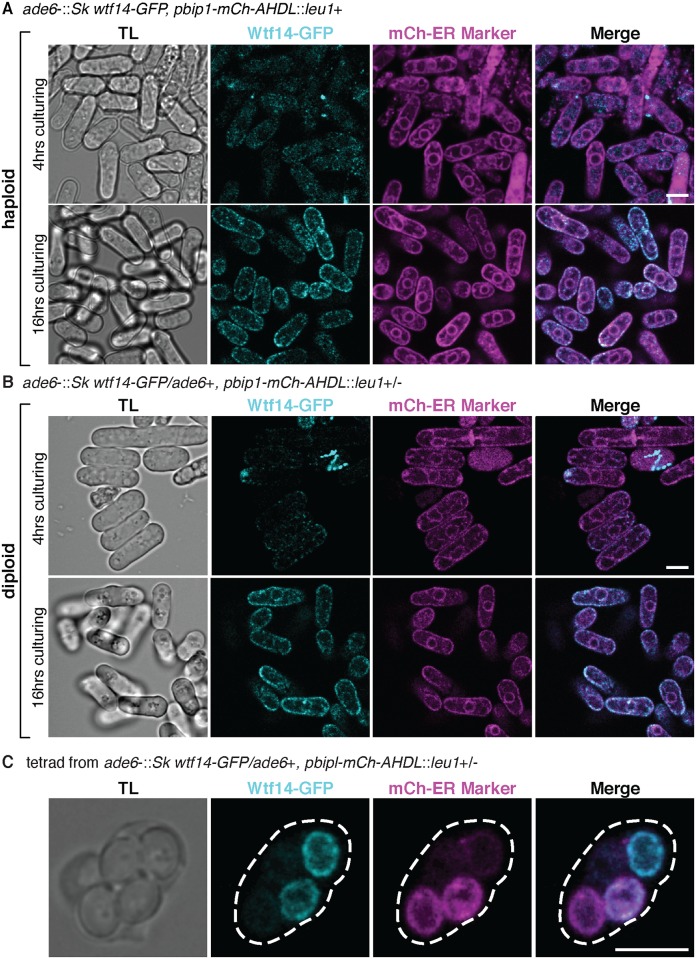
Sk wtf14-GFP is broadly expressed and localizes to the perinuclear endoplasmic reticulum (ER).Representative images of Sk Wtf14-GFP (cyan) and ER marker mCherry-AHDL (magenta) in (A) haploids and (B) diploids after 4 hours and 16 hours of culturing. The imaged diploids were heterozygous for both Sk wtf14-GFP and pbip1-mCh-AHDL. (C) Tetrad generated by a diploid heterozygous for Sk wtf14-GFP and pbip1-mCh-AHDL. We linearly unmixed the images in A and B (see Materials and methods, S10 Fig). We adjusted the brightness and contrast differently for each image and smoothed them using Gaussian blur. The scale bar represents 5 μm. TL, transmitted light.